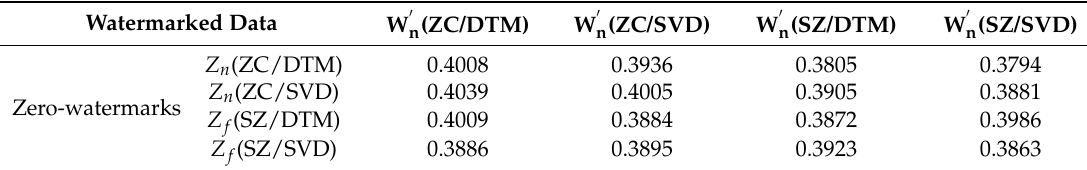
Table 6. Cross check results ( NC